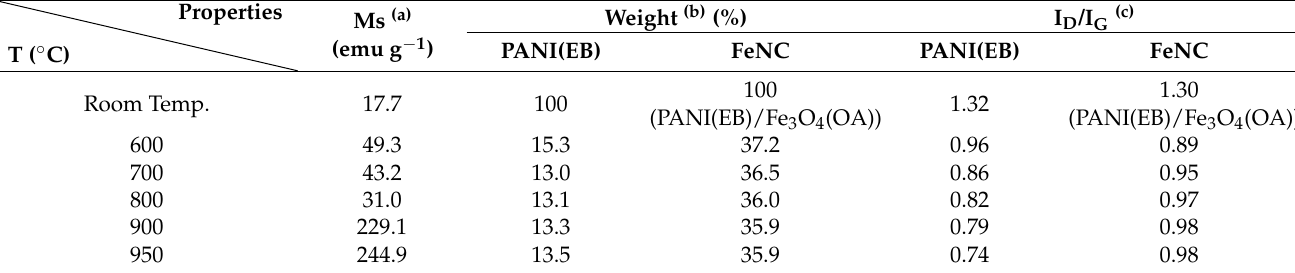
Figure 3. TGA thermograms of PANI(EB) and PANI(EB)/Fe 3 O 4 (OA). Table 2. Various properties of FeNCs vs. temperature.